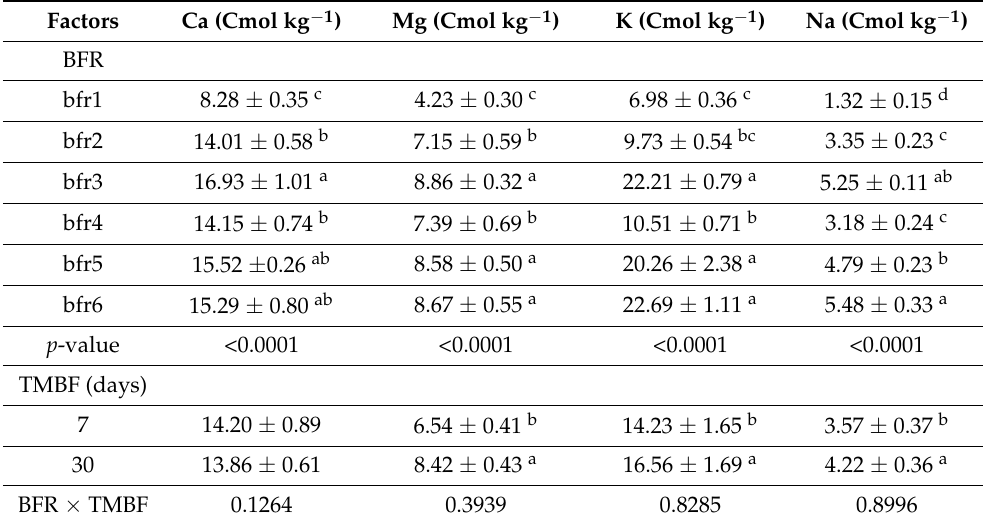
Table 3. Main and interaction effects of bokashi fertilizer ratios and time of bokashi fertilizer matura- tion on Ca, Mg, K, and Na contents.